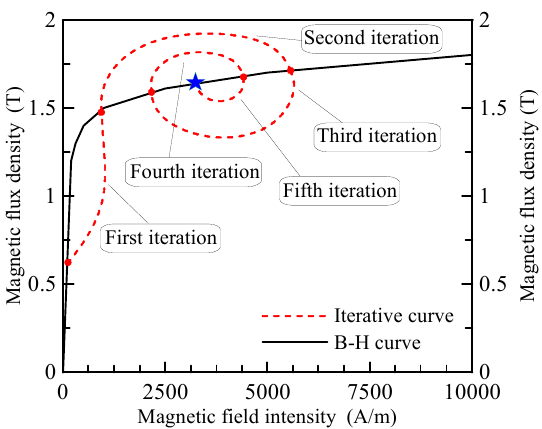
Figure 10. The B-H curve of DT4[29] (including iterative curve).